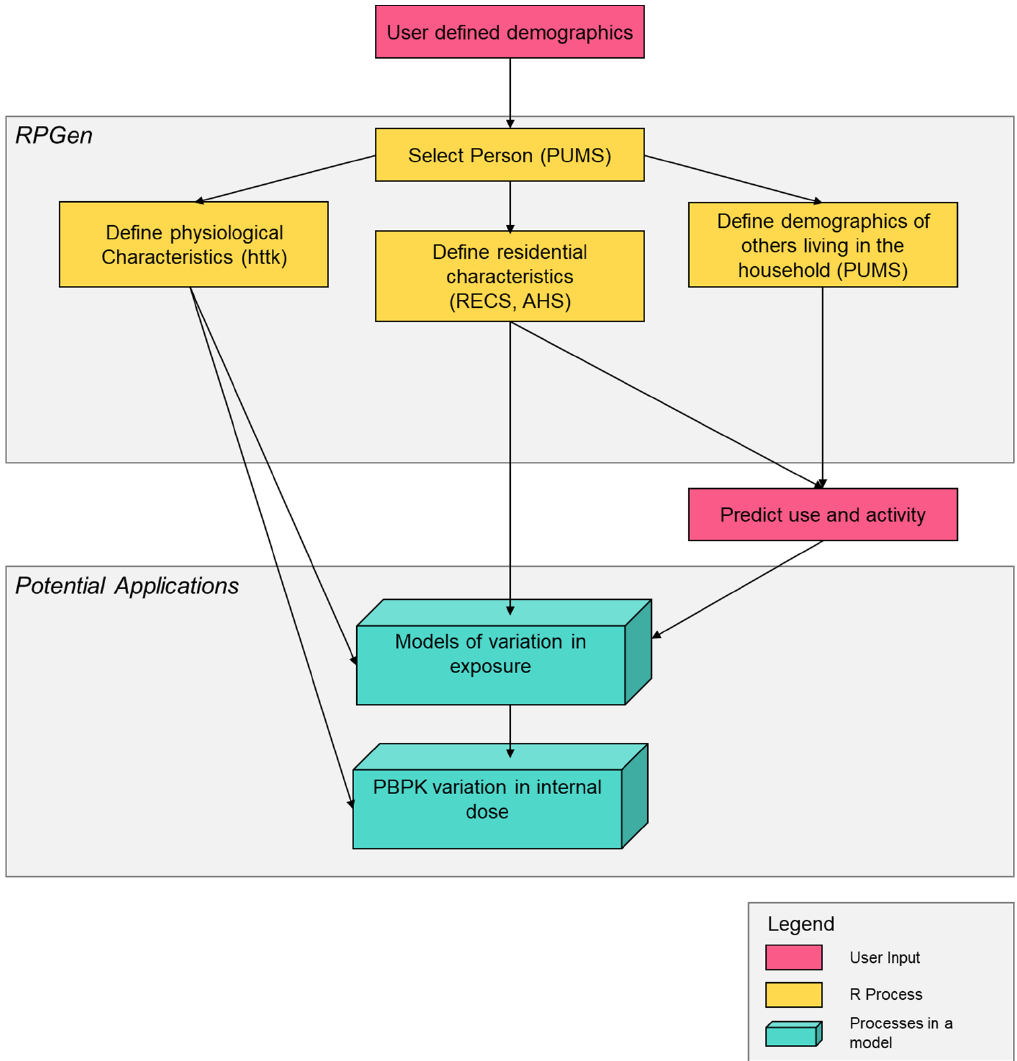
Figure 1. Role and internal process of RPGen in exposure and dose models. Note: Figure references the Public Use Microdata Survey (PUMS), the Residential Energy Consumption Survey (RECS), and the American Housing Survey (AHS).